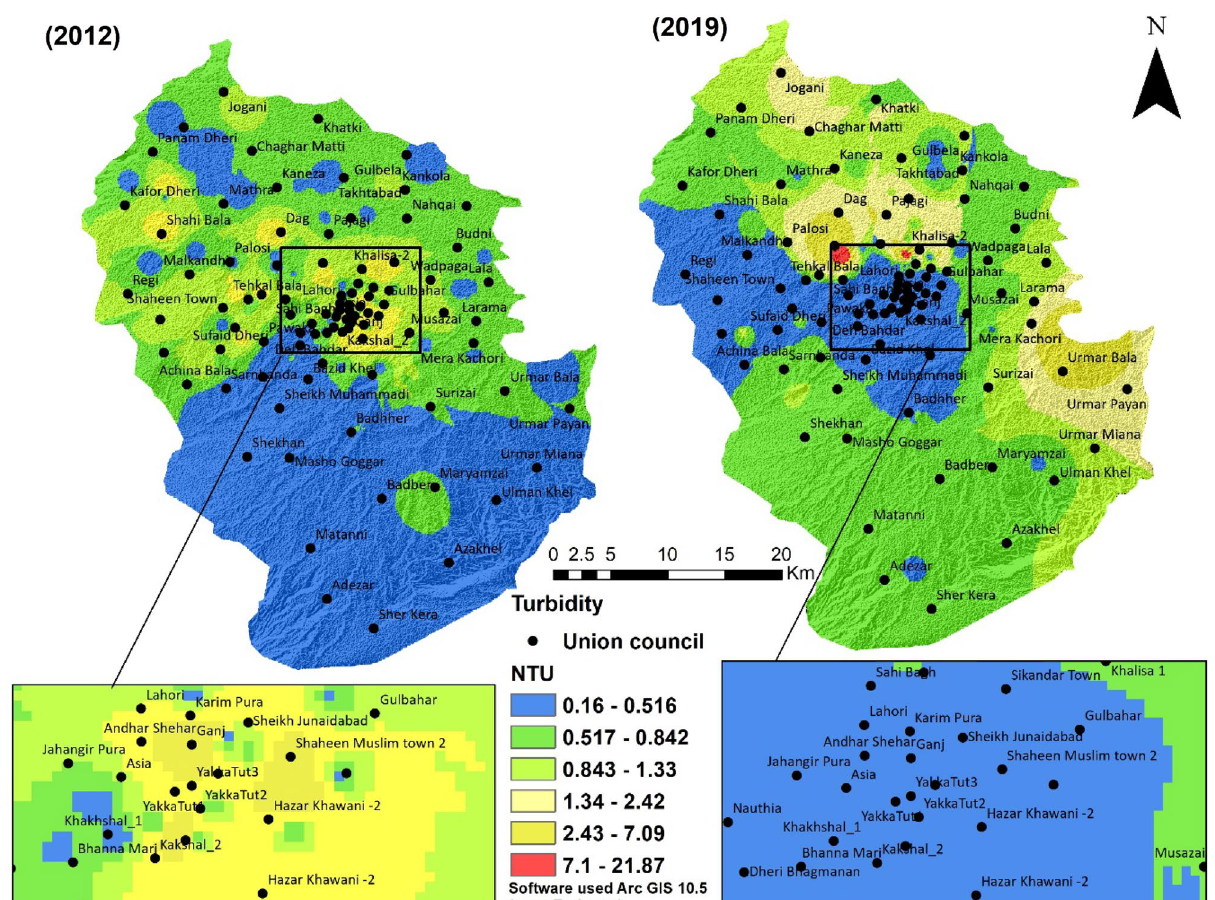
Figure 9. Turbidity of groundwater of the 2 years (2012 and